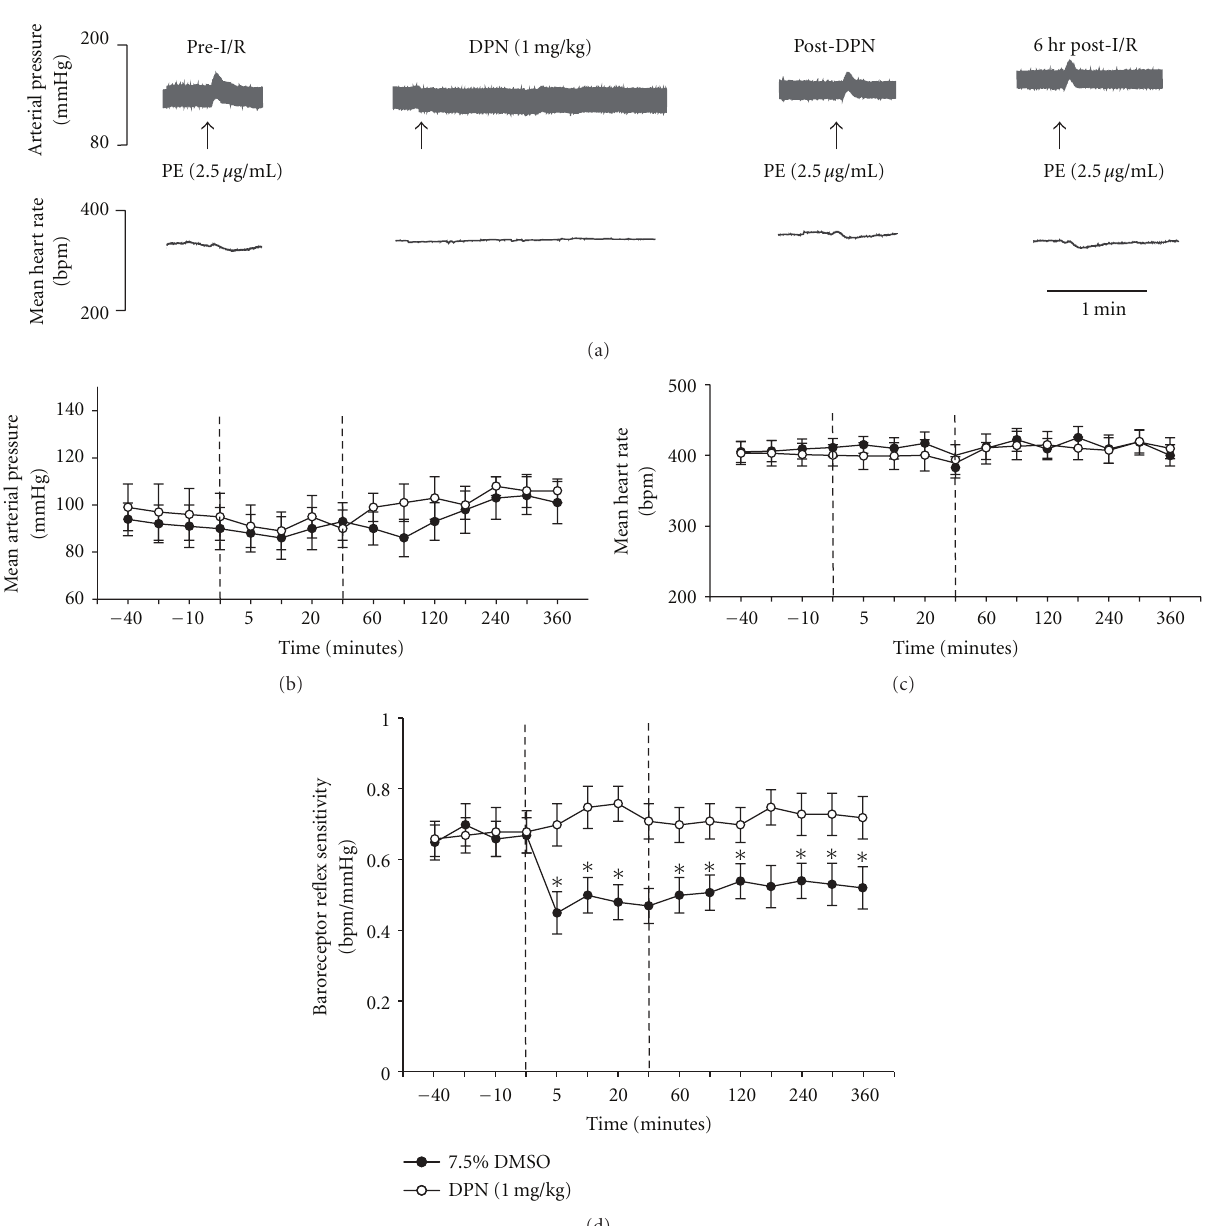
Figure 4: Cardiovascular responses to DPN (1mg/kg) or 7.5% DMSO pretreatment (i.v.; 30 minutes) prior to I/R. (a) Representative physiograph tracings of changes in arterial pressure and heart rate to phenylephrine injection (PE; 2.5 μ g/mL). Graphs represent average changes in mean arterial pressure (MAP; (b)), heart rate (HR; (c)), and baroreceptor reflex sensitivity (BRS; (d)). The first dashed lines represents the times at which the MCA was occluded and the second line indicates when blood flow was returned (reperfusion). Each data point represents the mean ± S.E.M ( n = 4–6/group), and ∗ indicates significance ( P ≤ . 05) from baseline values.